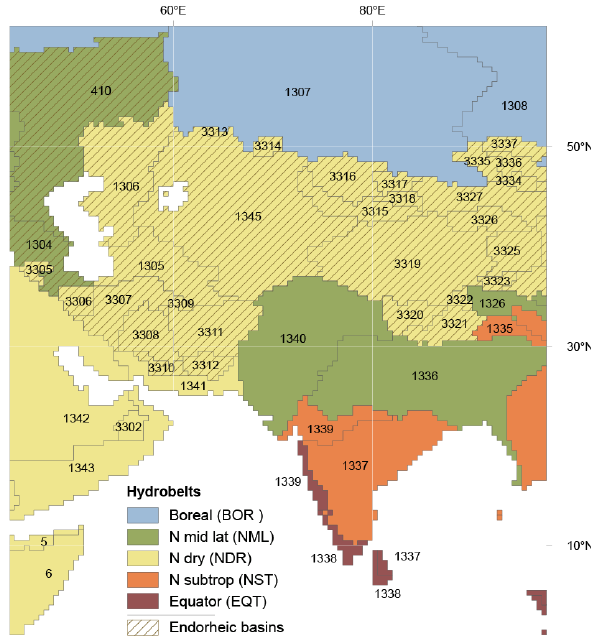
Fig. 1. Delineation of coastal catchments (COSCATs), exorheic and endorheic river basins and their aggregation into hydrobelts: exam- Figure 1. Delineation of coastal catchment (COSCATs), exorheic and endorheic river ple of Central and South Asia. COSCATs coding (except endorheic regions) from Meybeck et al. (2006) (see Supplement for tabulated basins and their aggregation into hydrobelts: example of Central and South Asia. 1115 information and coding of the endorheic COSCATs coding (except endorheic regions) from Meybeck et al. ( 2006) (See Supplement for tabulated information and coding of the endorheic COSCATs).